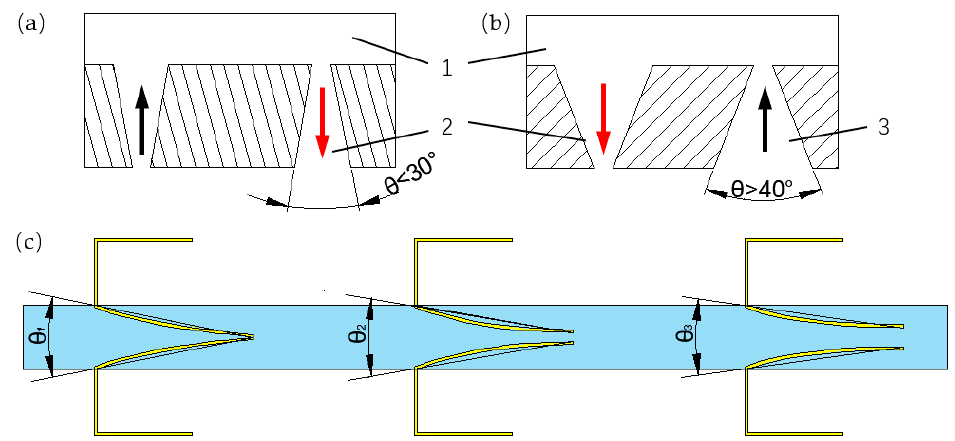
Figure 11. The cone angle of PZT pump: ( a ) the pumping direction when the cone angle was below 30°; ( b ) the pumping direction when the cone angle was above 40°; ( c ) the flare angle change of the compliant structures; (1) the chamber; (2) the outlet; (3) the inlet.